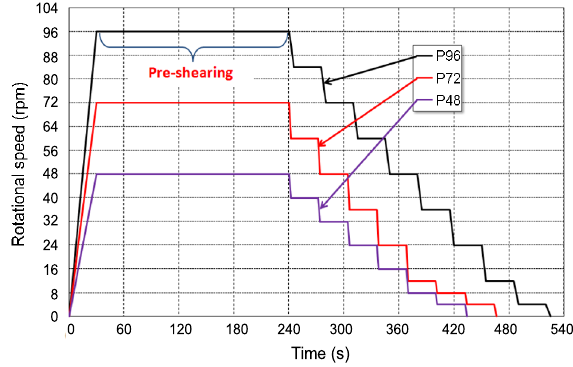
Fig. 3. The tested velocity